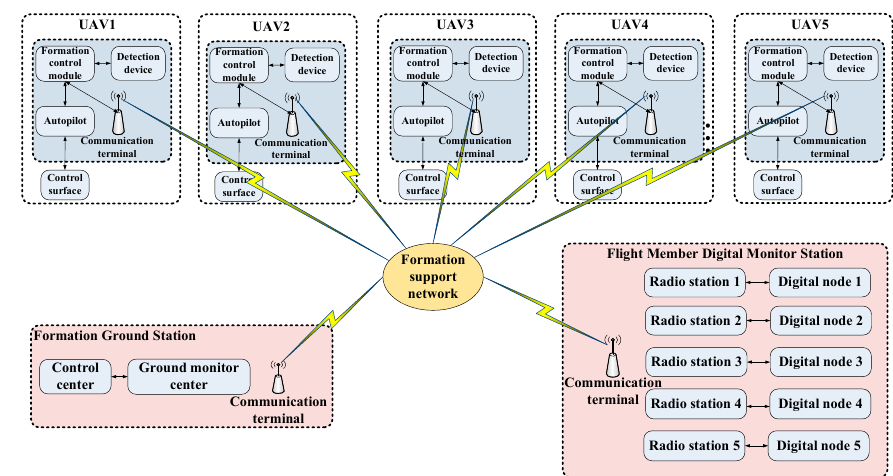
Figure 9. The framework of the USCC outfield flight system.